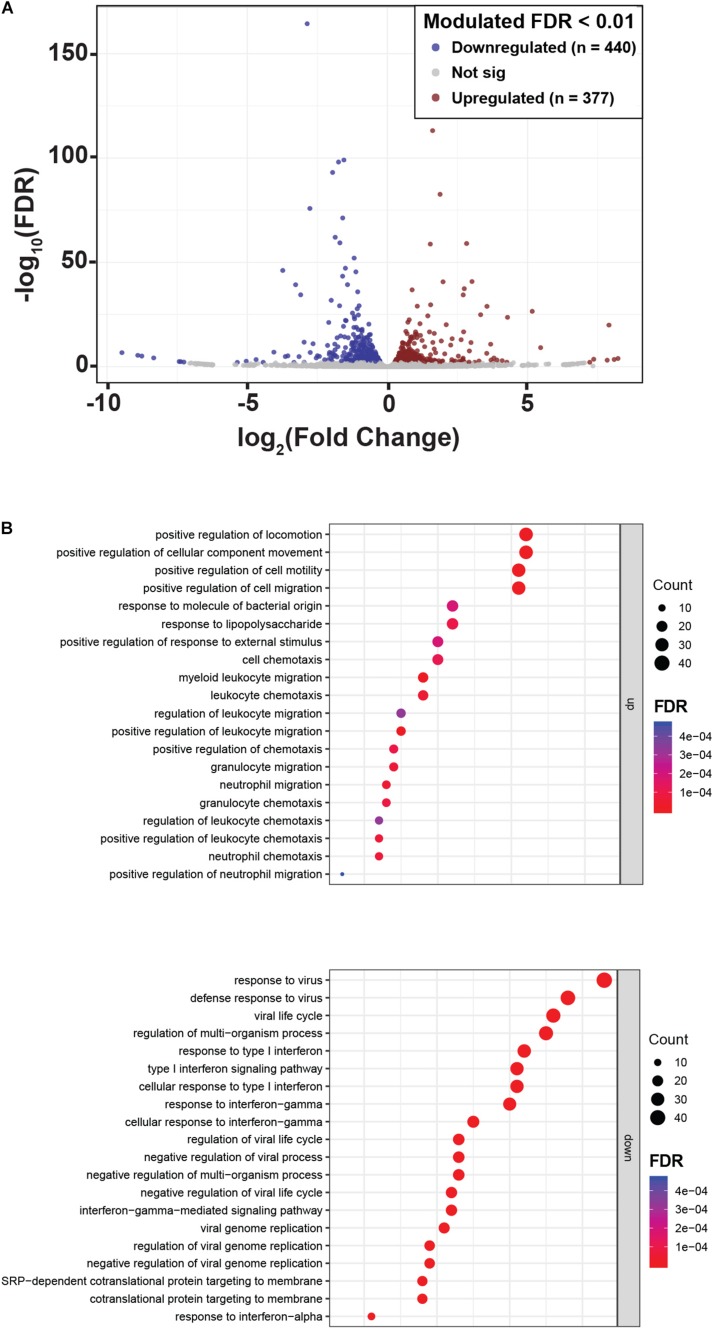
NLRP2 upregulates biological processes that are mainly involved in immune responses and chemotaxis, and downmodulates the expression of interferon inducible genes. (A) A volcano plot displaying the 817 differentially expressed genes in PTEC/NLRP2 versus PTEC/EV. Axes show logarithmic transformation of fold change (x-axis) and p-values (false discovery rate, FDR). Genes upregulated and downregulated in PTEC/NLRP2 with a p-value < 0.01 are represented in red and in blue, respectively. (B) Genes with differential expression were subjected to gene ontology (GO) analyses. The top 20 most significantly upregulated (upper panel) and downregulated (lower panel) biological processes are shown.